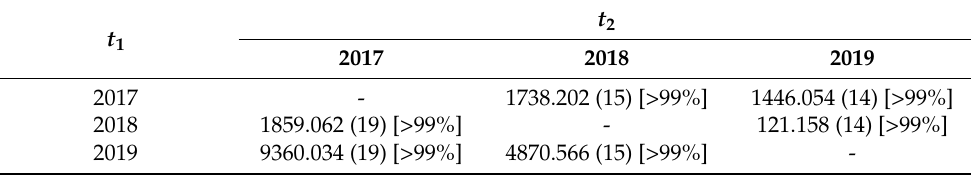
Table 5. Likelihood ratio test results between different periods based on a random parameter approach with heterogeneity in means and variances in non-helmet-wearing motorcyclists’ crash data ( χ 2 values with degrees of freedom in parenthesis and confidence level in